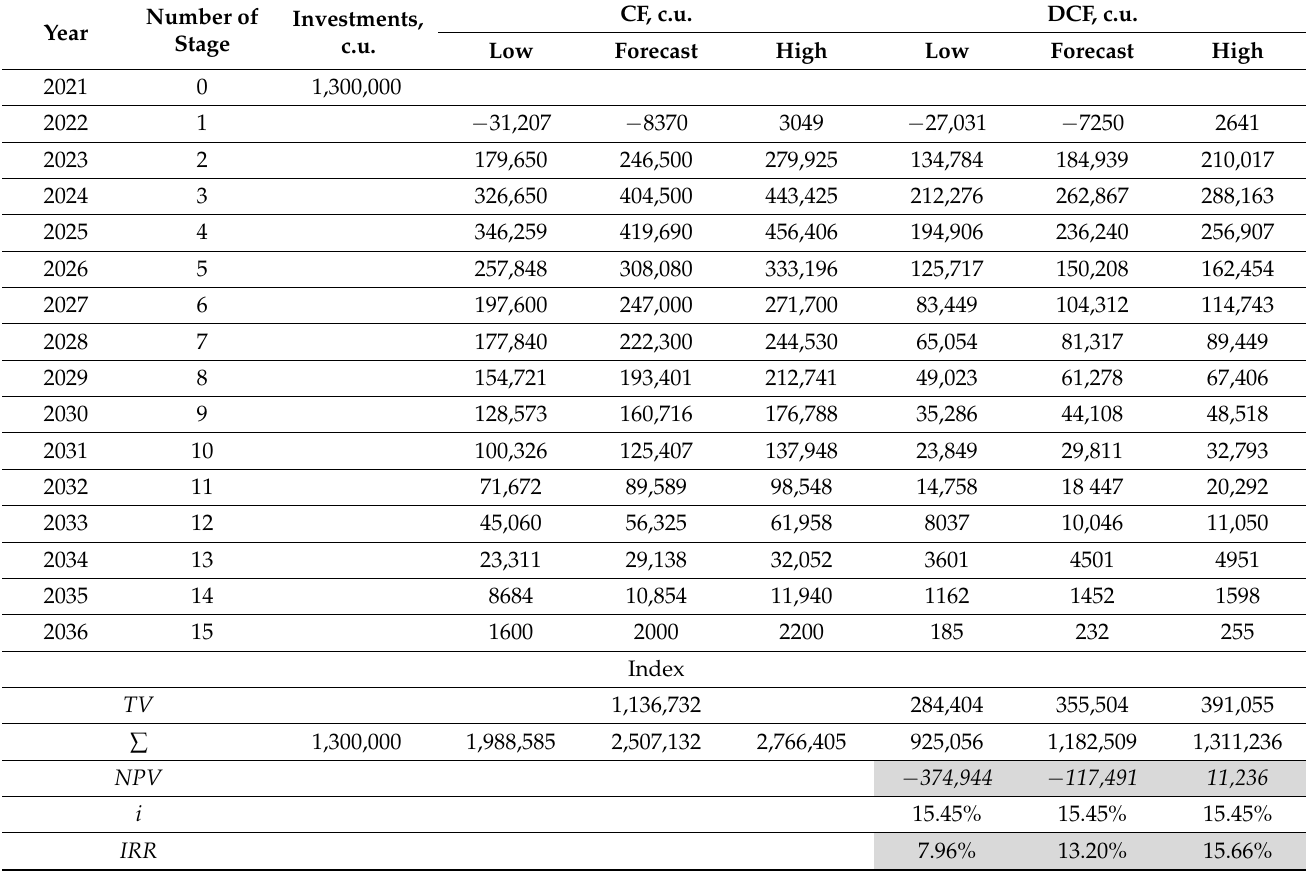
Table 2. Financial model of the innovation